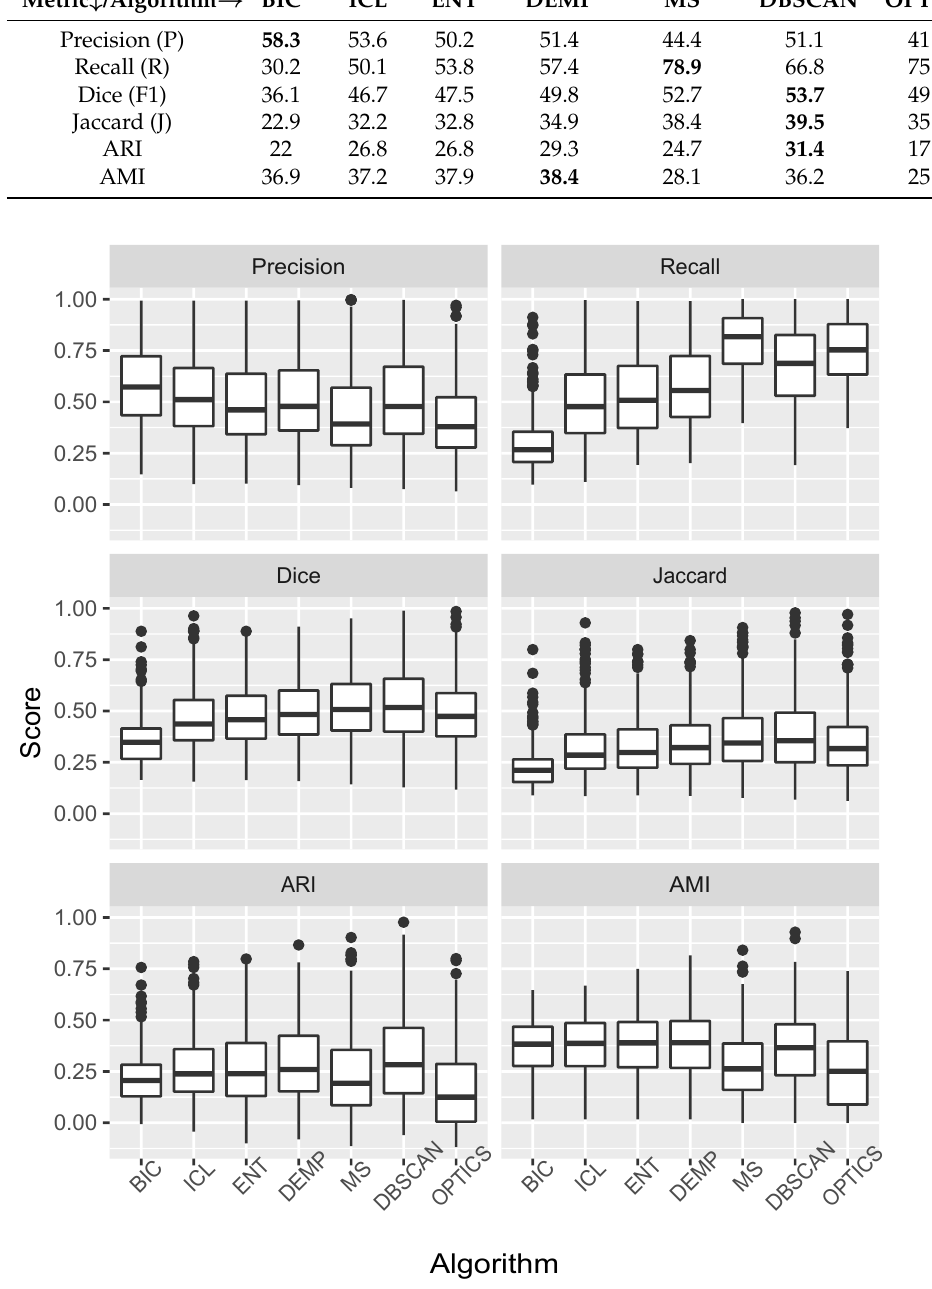
Figure 8. Boxplots of the metric distribution using different clustering algorithms for the Berkley image segmentation